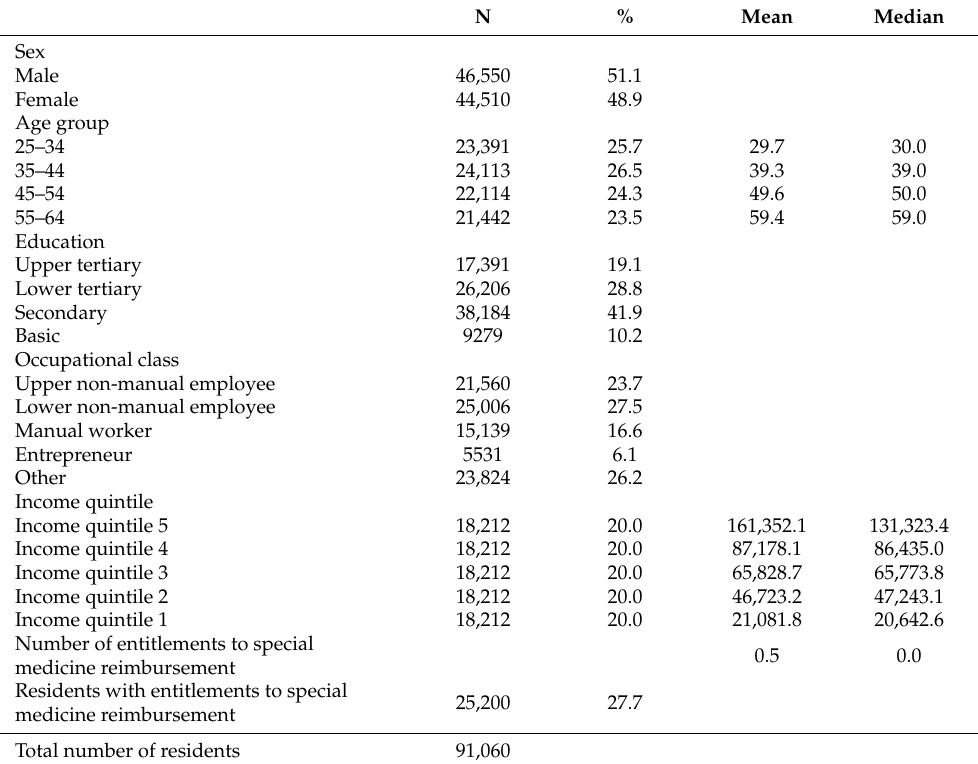
Table 1. Descriptive statistics for the covariates of working-age (25–64) residents of Oulu in